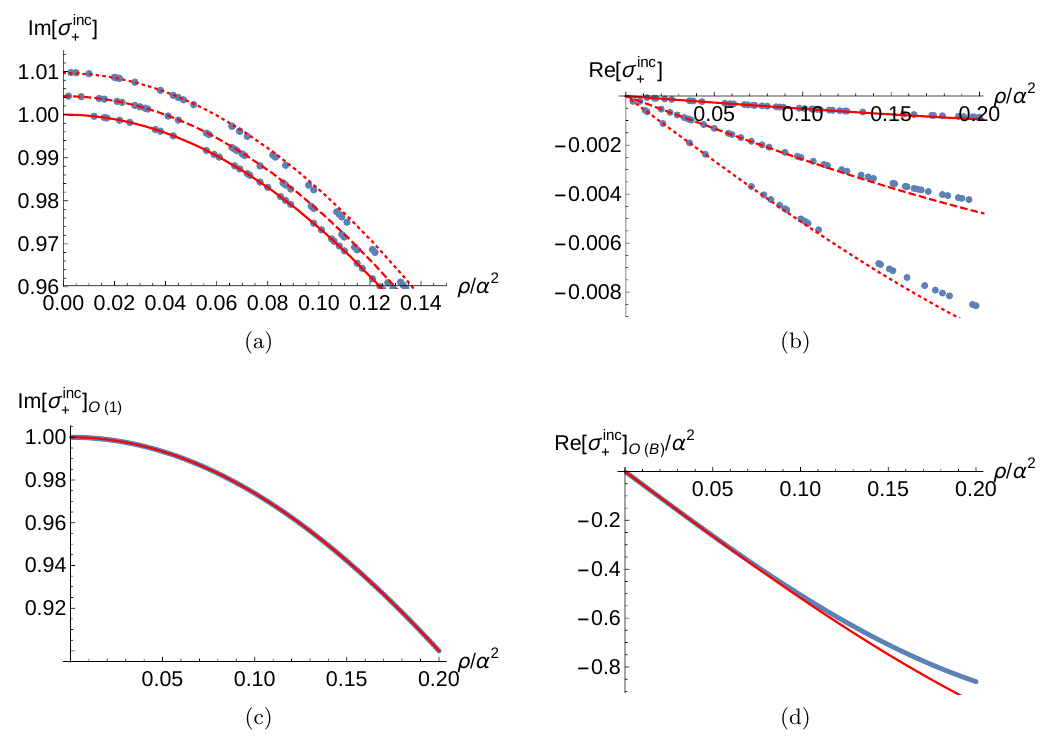
Figure 1 : Plots of the constant term in the Laurent expansion of the charge correlator about the hydrodynamic pole against the charge density. The blue dots are data. Upper left: the imaginary part of (cid:27) inc : against our analytic expression for (cid:27) . The three red lines 0 + represent B=(cid:11) 2 = 1 = 1000 (solid), 1 = 25 (dashed) and 3 = 50 (dotted). Notice that (cid:27) > 1 0 which stands in contradiction to the standard prescription where (cid:27) = ( sT= ( " + P )) 2 (cid:20) 1. 0 Upper right: the real part of (cid:27) inc : against our analytic expression for ~ (cid:27) . The three red H + lines represent B=(cid:11) 2 = 1 = 1000 (solid), 5 = 1000 (dashed) and 10 = 1000 (dotted). Lower left: the leading contribution at small B to the imaginary part of the constant term. The solid red line is the analytic expression for [ (cid:27) ] . Lower right: the O ( B 1 ) contribution to the 0 B =0 constant part of the Laurent expansion. The red line is our analytic result for [~ (cid:27) ] . H B =0 Additionally, in (cid:12)gure 1 we display [ (cid:27) ] against the numerically extracted constant 0 B =0 Laurent coe(cid:14)cient at low B in the lower left hand plot of (cid:12)gure 1 and the matching is excellent. In the lower right plot we also show [~ (cid:27) ] . The match is a little less accurate H B =0 as (cid:26) increases, or equivalently T decreases. This is most likely due to higher order